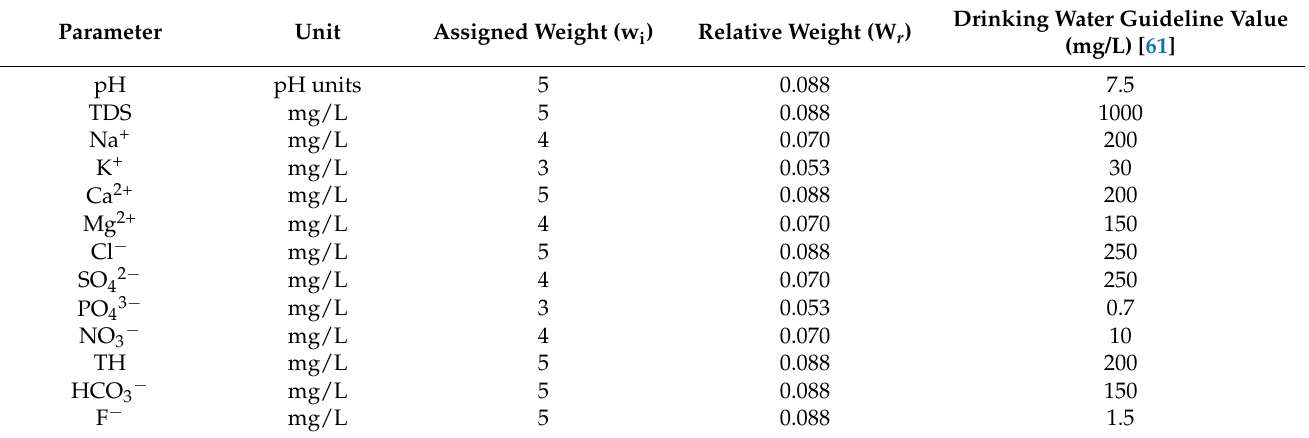
Table 1. Numerical weights, relative weights, and standard values of the parameters used to estimate the water quality index